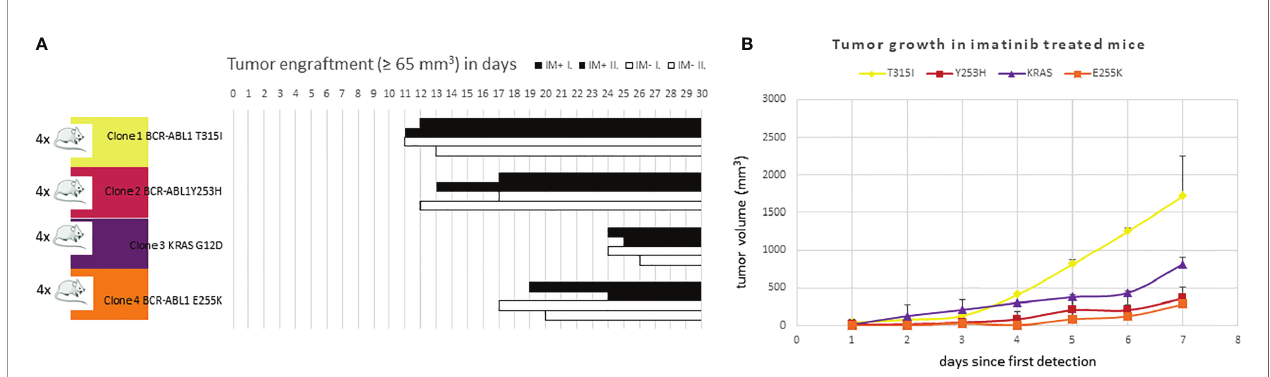
FIGURE 6 | The ef fi cacy of (A) engraftment and (B) tumor growth of imatinib-resistant KCL-22 clones in NSG mice. (A) A total of 1x10 6 cells of individual resistant clones were subcutaneously inoculated into mice (n = 4 per clone). After three days, mice were randomly distributed into imatinib-treated (n = 2 per clone; 100 mg/ kg in PBS 1 x per day by oral gavage; IM+; black columns) and untreated/control (n = 2 per clone; 200 µl PBS 1 x per day by oral gavage; IM-; white columns) groups and monitored for tumor detection. The X-axis represents days since transplantation. Bars represent detected and growing tumors. (B) Tumor growth of imatinib-resistant KCL-22R clones in NSG mice treated with imatinib. The X-axis represents days since the fi rst tumor detection. The Y-axis represents tumor volume. Error bars represent standard